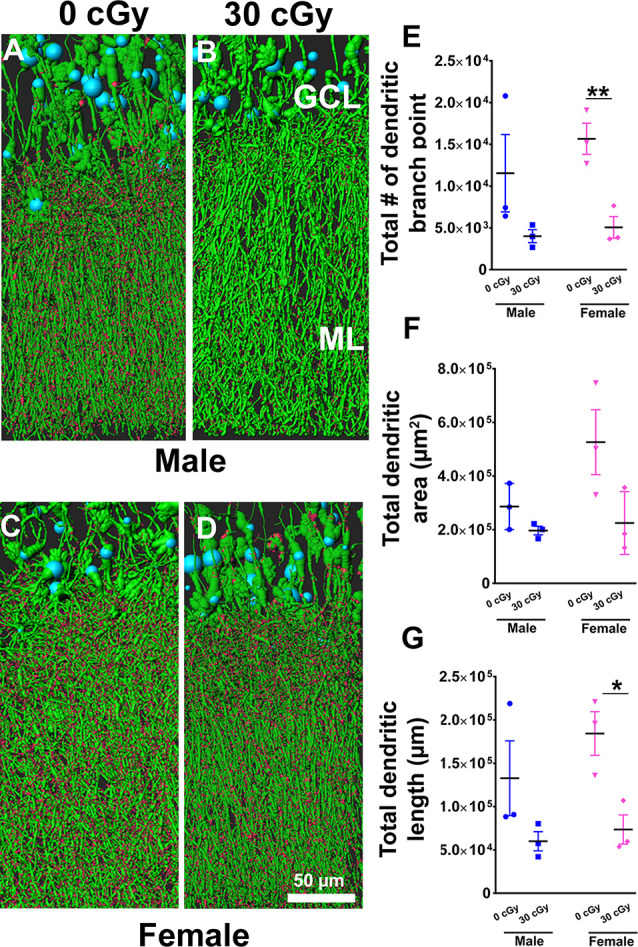
Dendritic complexity of dentate gyrus granular cell layer (GCL) neurons was altered in females not in males by 4He ion irradiation (A–D). Examples of deconvoluted EGFP+ GCL neurons showing dendrites orientated vertically and traversing the molecular layer (ML) along with dendritic spines projecting into the ML. Two-way ANOVA (sex × radiation) performed on dendritic branch points (E), area (F), and length (G) confirmed no sex × radiation interaction (dendritic branch points, p = 0.57; area, p = 0.19; length, p = 0.50) and no main effect of sex (dendritic branch points, p = 0.35; area, p = 0.11, length, p = 0.26) but did show a significant effect of irradiation (dendritic branch points, p = 0.008; area; p = 0.03; length, p = 0.01). Radiation was found to decrease branch point and total dendritic length in female mice, but not male mice [branch point, p = 0.009 (E); dendritic length, p = 0.02 (G); unpaired t-tests]. Data are expressed as the mean ± SEM, *p < 0.05, **p < 0.01 unirradiated controls. N = 3 for each experimental group. Blue (cell body), green (dendrites), and red (dendritic spines).